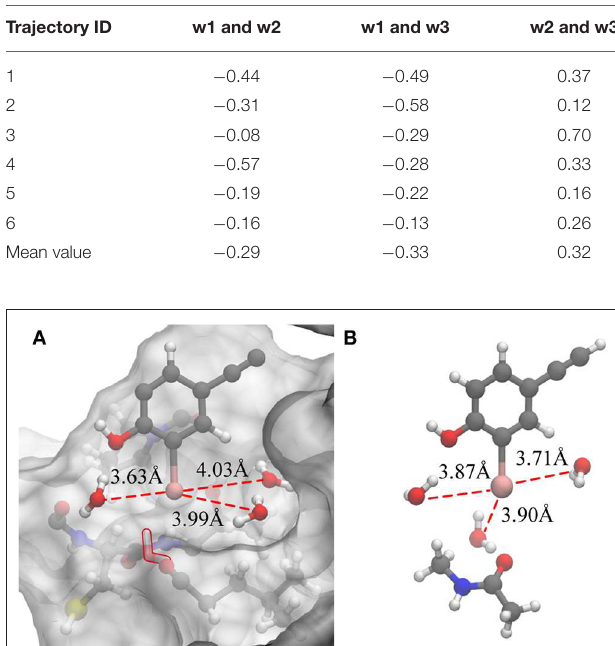
FIGURE 7 | Changes in the hydrogen bonds formed by the three water molecules and the iodine atom in a protein-rich environment and under vacuum. (A) The QM/MM-minimized structure of model 2 in the protein environment. (B) The optimized simplified QM structure in vacuum (at the MP2/aug-cc-pVTZ-PP level of theory for I and at the MP2/aug-cc-pVTZ level of theory for H, C, N, and